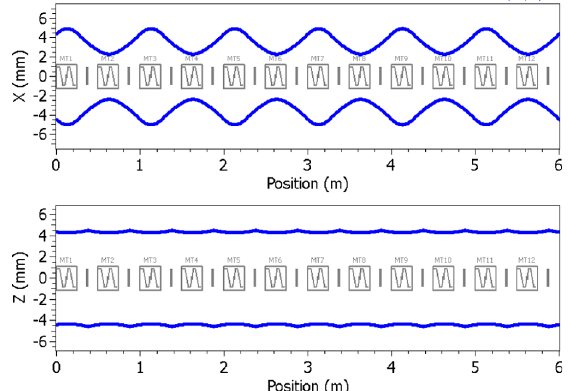
FIG. 1. TRACEWIN envelopes for reference transport channel with rf focusing gaps.